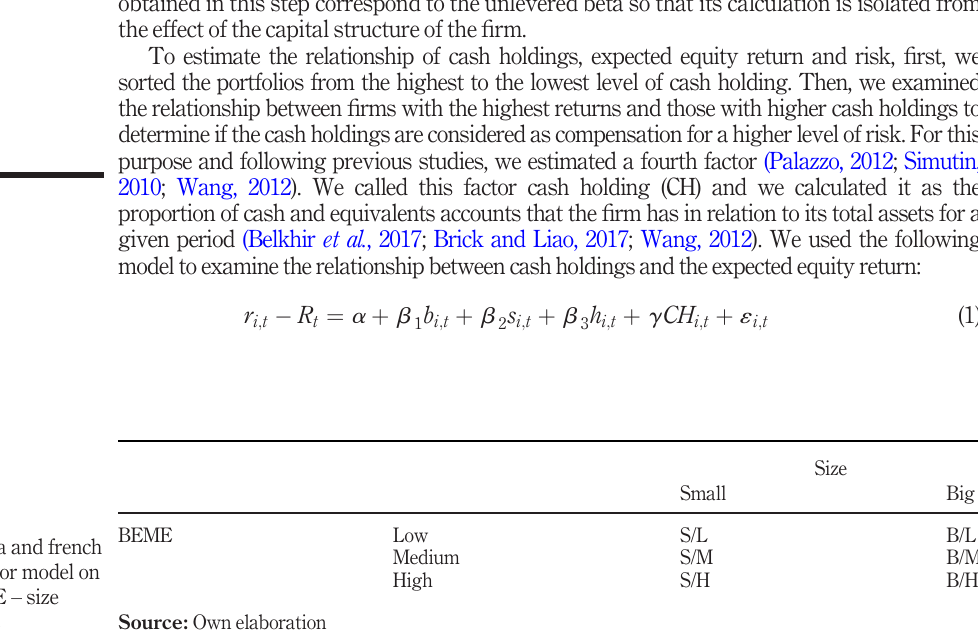
Table 4. The Fama and french three-factor model on six BEME – size